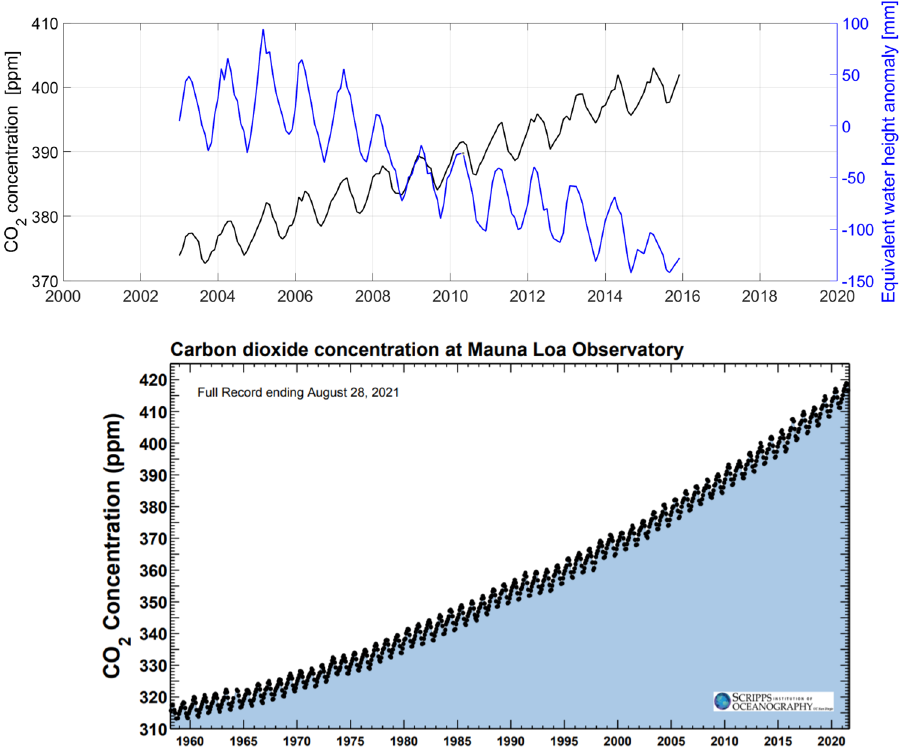
Figure 2. Time series of EWH anomaly and CO 2 concentration from 2003 to 2015 over Iran (top) and full record of CO 2 concentration (Scripps Institution of Oceanography at UC San Diego)